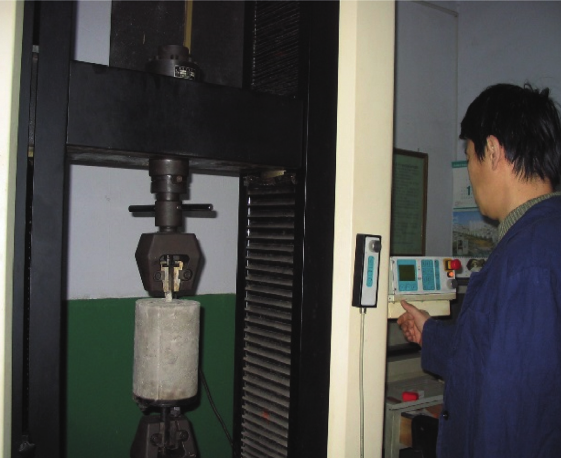
Figure 3: Sample mounted on the testing Table 2: Material properties of the cement mortar.